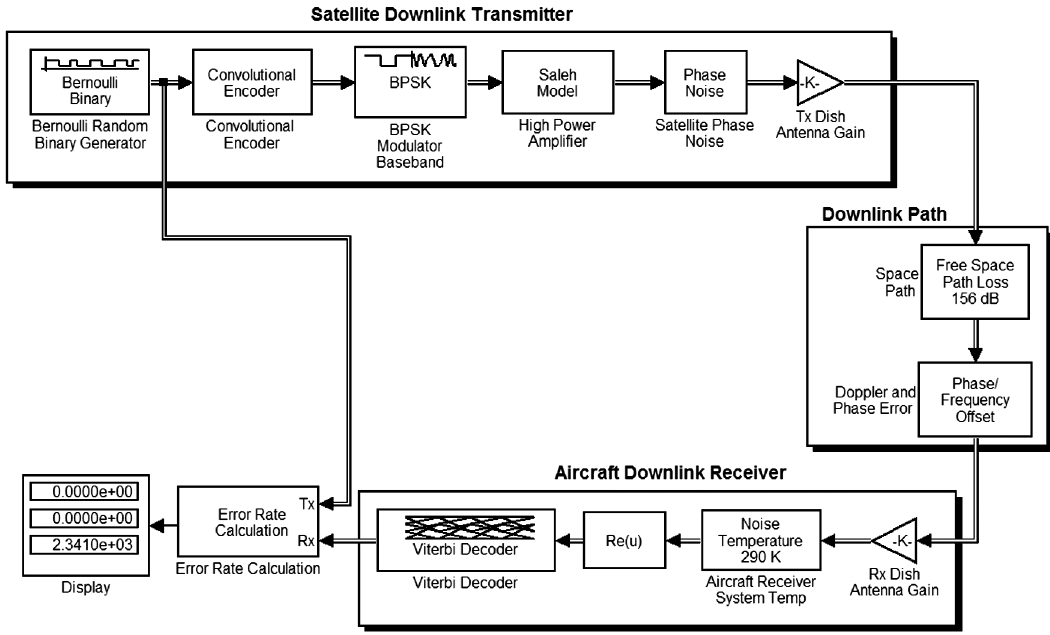
Fig. 2. ‘Satellite-to-Aircraft’